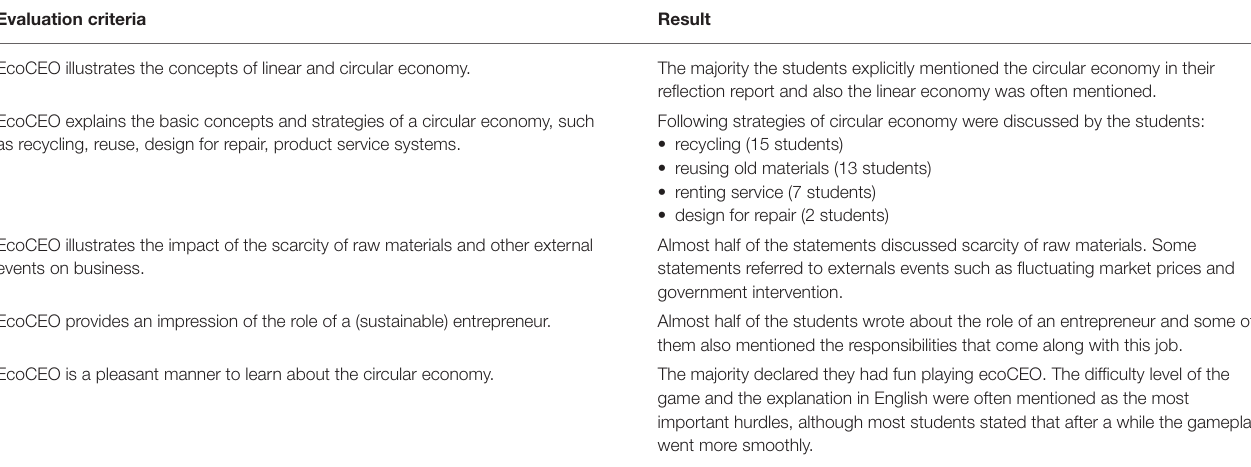
TABLE 9 | Comparison evaluation criteria and